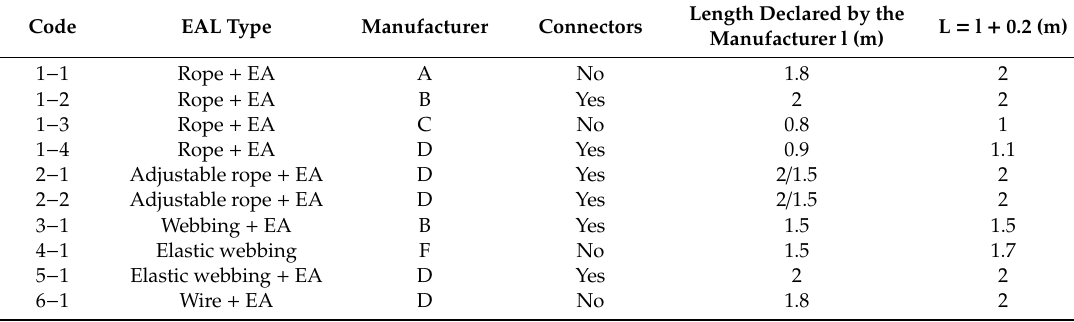
Table 2. Technical specifications of samples according to the manufacturer’s instruction manual .